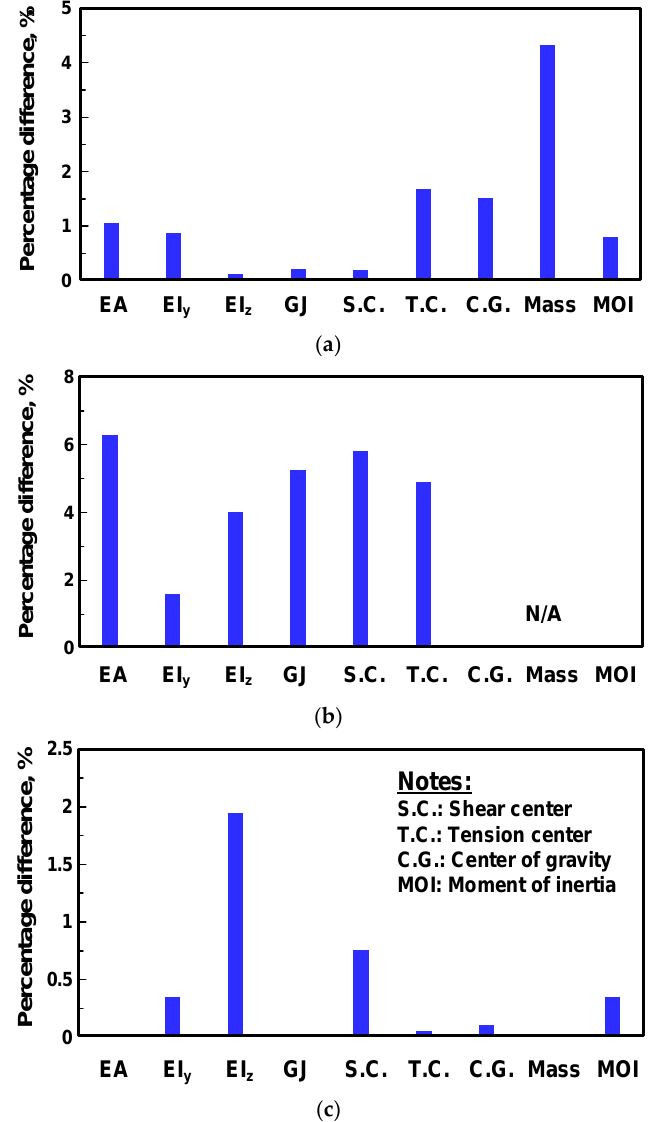
Figure 18. Sensitivity results on structural properties of the design parameters. ( a ) Effect of cable modeling, ( b ) effect of nose weight modeling, and ( c ) effect of imperfections on TE spar modeling.